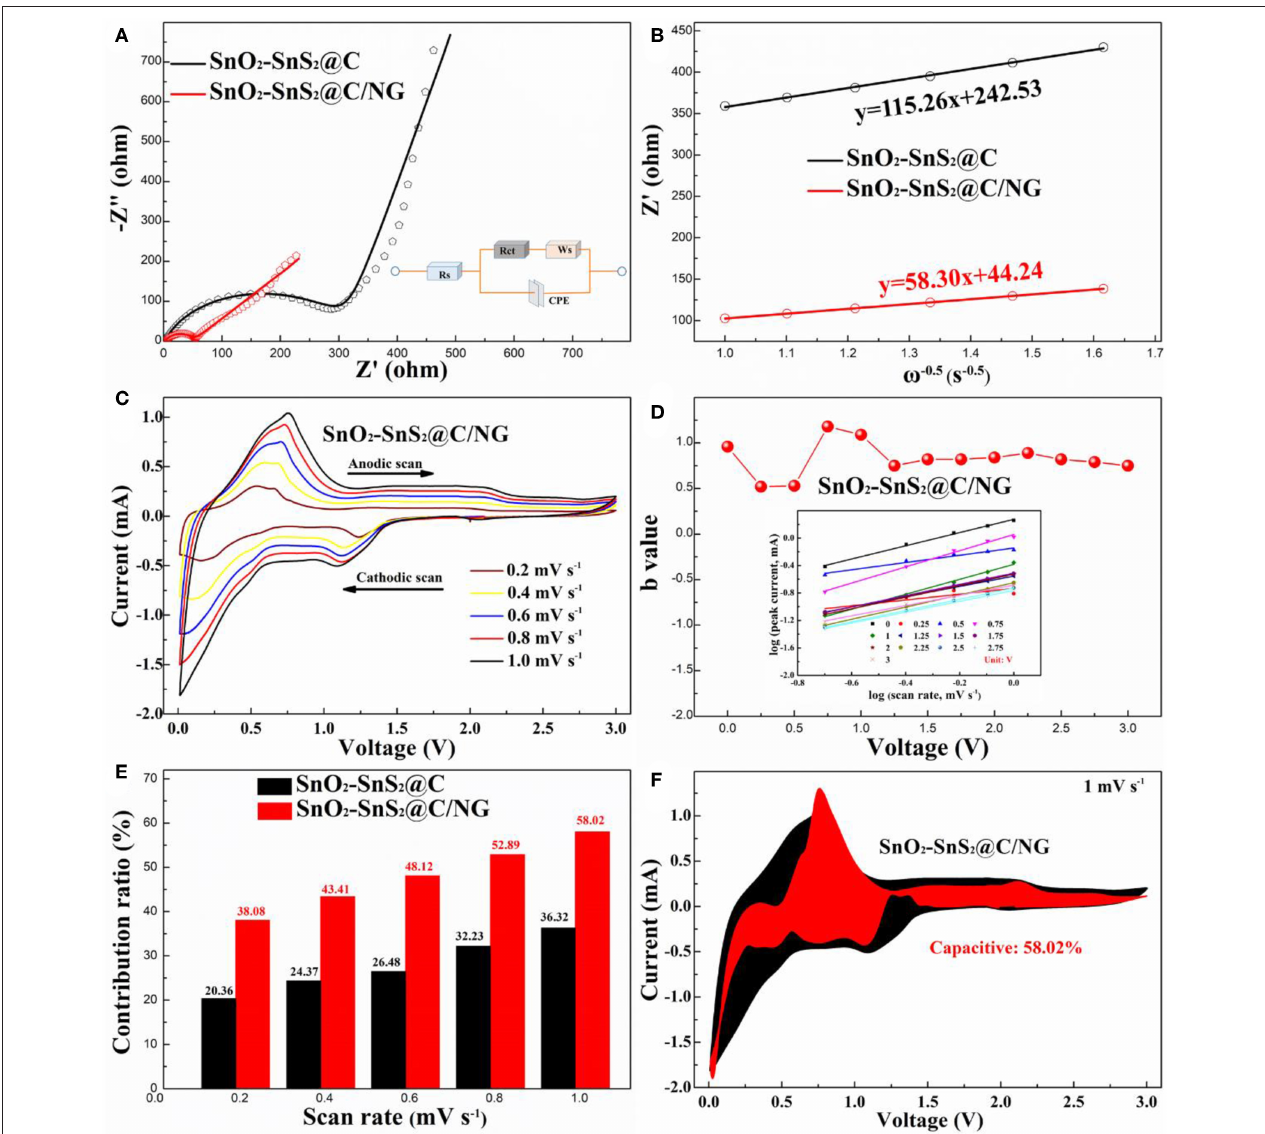
FIGURE 6 | (A) Nyquist plots and corresponding fitted curves of SnO 2 -SnS 2 @C and SnO 2 -SnS 2 @C/NG electrodes before cycles (the inset is the modified equivalent circuit); (B) Nyquist plots and corresponding relationship between the real resistance (Z’) and angular frequency ( ω − 0.5 ) for SnO 2 -SnS 2 @C and SnO 2 -SnS 2 @C/NG electrodes; (C) CV curves of SnO 2 -SnS 2 @C/NG electrode at different scan rates from 0.2–1.0mV s − 1 ; (D) b values plotted against cell voltage of SnO 2 -SnS 2 @C/NG electrode for cathodic scans; (E) the percentage of the capacitance contribution for SnO 2 -SnS 2 @C and SnO 2 -SnS 2 @C/NG at different scan rates; (F) CV curve of SnO 2 -SnS 2 @C/NG at a sweep rate of 1.0mV s − 1 , and the estimated capacitive current contribution is shown in the shaded